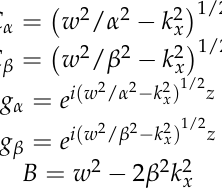
The 4 × 4 matrix in Equation (2) is defined as a coefficient matrix [ D ], which represents the relationship between displacement–stress and amplitude. In a multilayer thin film with n layers, the relationship between amplitude and displacement/stress is defined by the coefficient matrix [ D ], which can be expressed by Equation Here, the amplitude of the ultrasonic wave traveling in the depth direction of the thin film structure is represented by + subscript, and that traveling in the opposite direction is represented by the—subscript. The variables, (cid:1829) (cid:3080) , (cid:1829) (cid:3081) , (cid:1859) (cid:3080) , (cid:1859) (cid:3081) and (cid:1828), are arbitrarily desig- nated abbreviations for convenience of calculation and are expressed as follows.